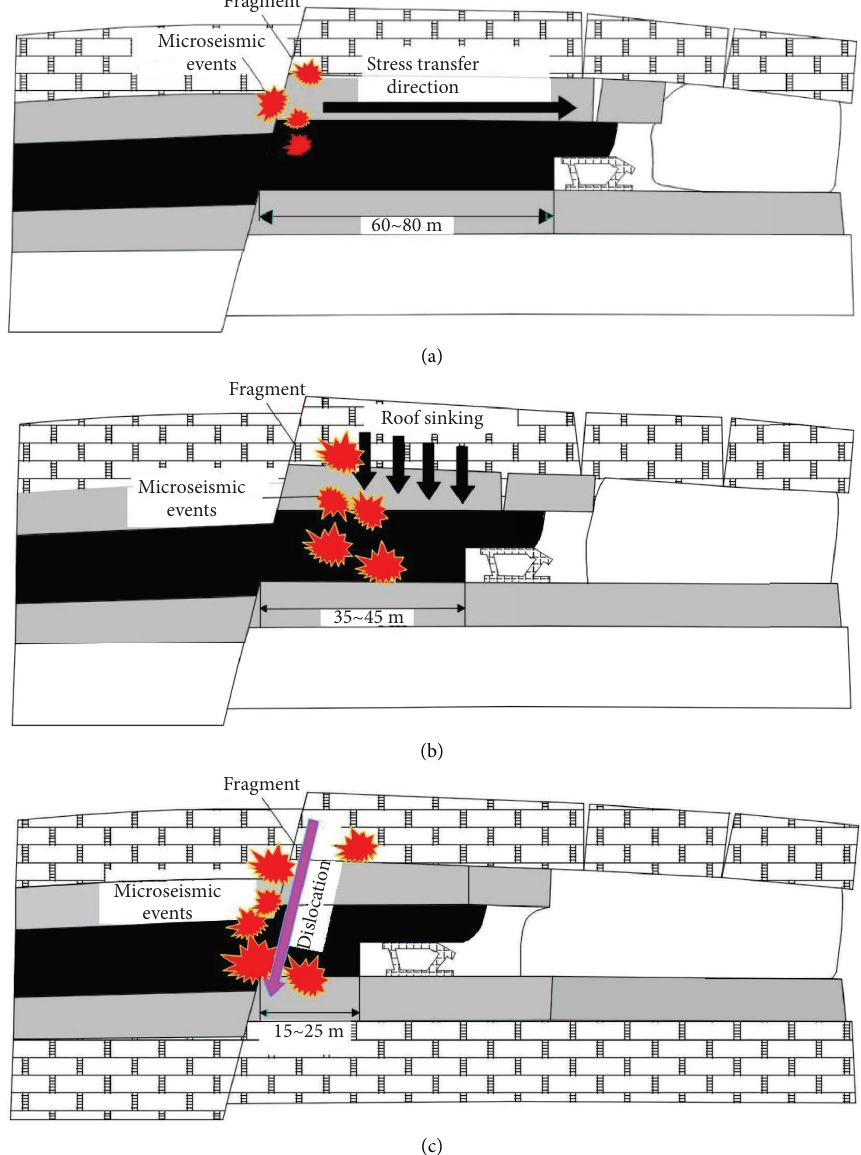
Figure 9: Rock burst-induced principle of fault coal mine earthquake. (a) Rock burst mechanism induced by fault activation. (b) Rock burst mechanism induced by fault coal pillar. (c) Rock burst mechanism induced by fault